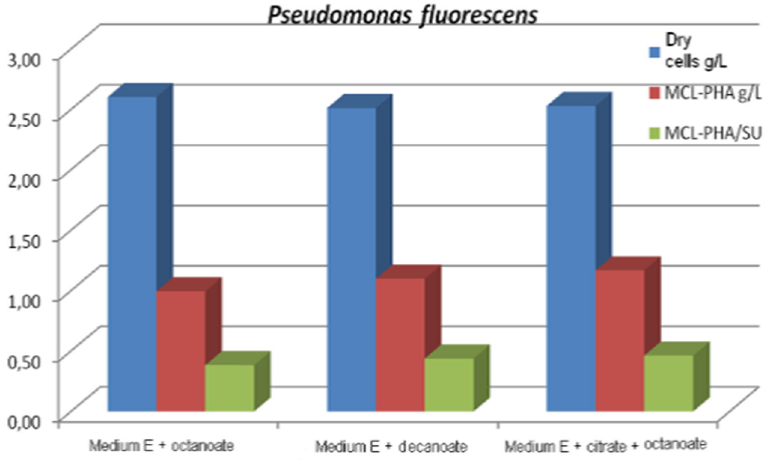
Figure 3. Biomass and mcl -PHA production Reprinted with permission from ref. [65], 2014, Vladu et al., Studia